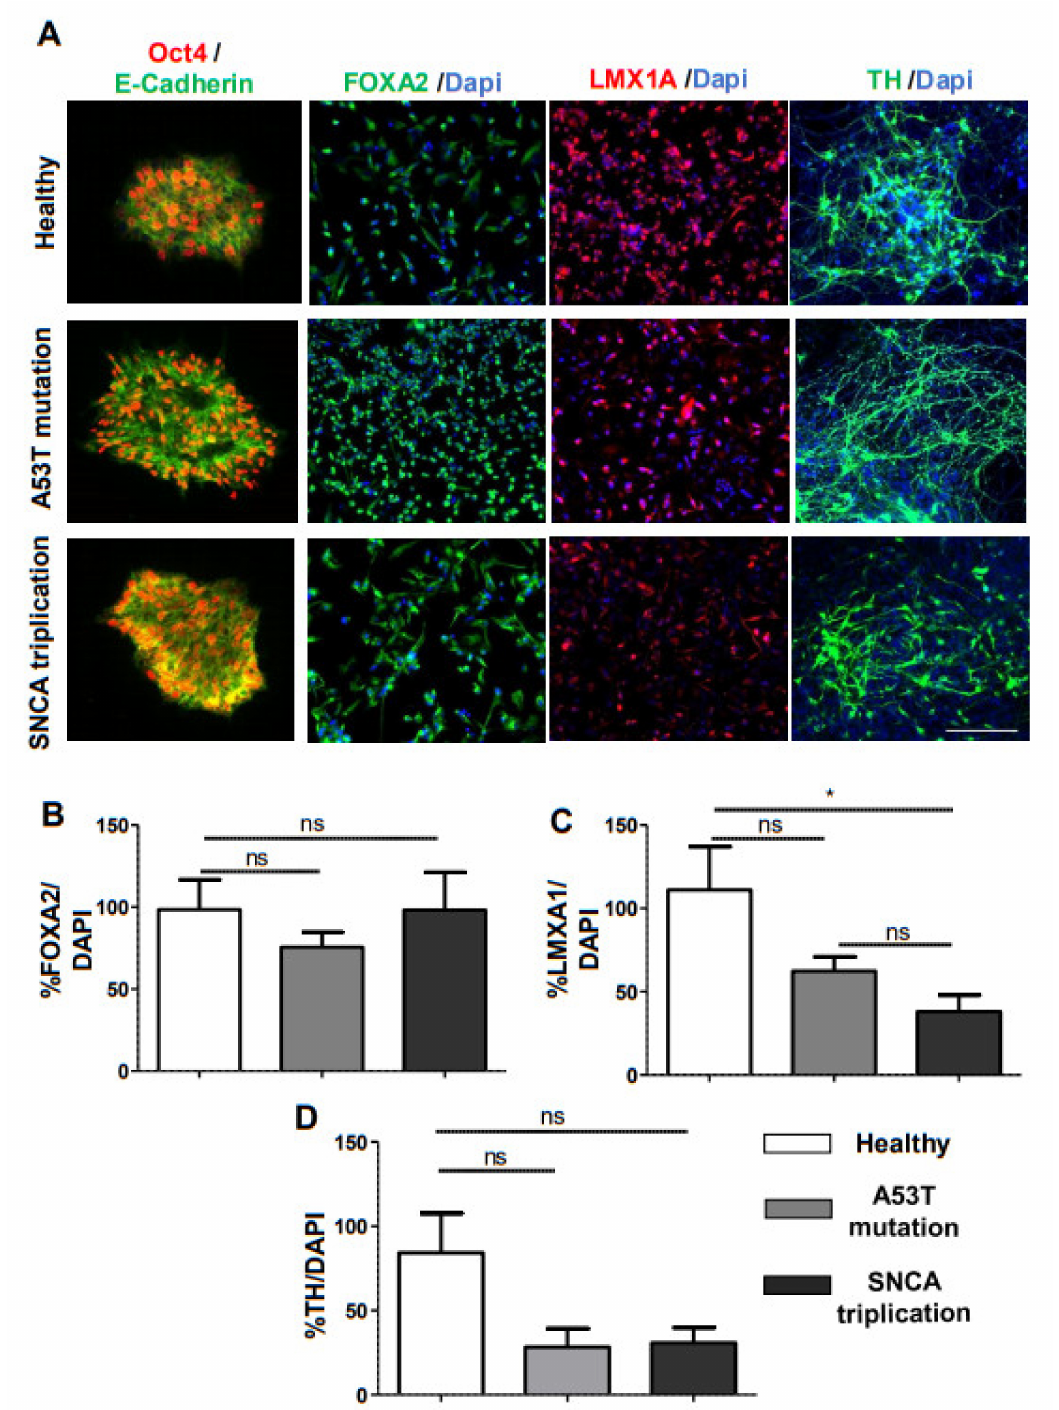
Figure 2. Characterization of iPSC-derived mDA neurons from a healthy subject and fPD patients. ( A ) We performed immunostaining with stem cell markers Oct4 and E-cadherin at day 0, midbrain neural precursor marker FOXA2 and LMX1A at day 11, and dopaminergic neuronal marker TH for healthy human and fPD patients (A53T mutation and SNCA triplication) at day 30. Next, we quantified the levels of immunostaining for ( B ) FOXA2, ( C ) LMXA1A, and ( D ) TH in healthy and fPD lines using image analysis. Images are representative of at least three independent differentiations. All data in the graphs are presented as mean ± standard error of the mean (SEM) of three images acquired from three different coverslips. Data were analyzed by one-way analysis of variance (ANOVA) followed by Tukey’s multiple comparison post hoc test. * p < 0.05; Scale bar is 100 µ